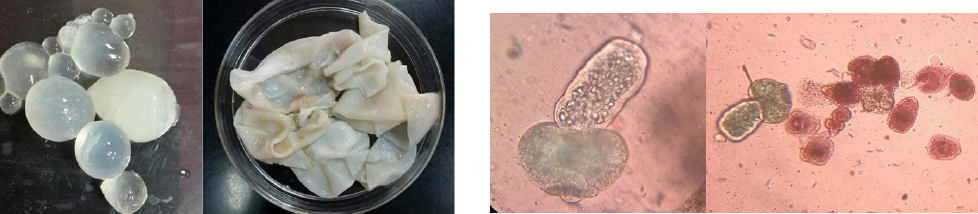
Fig. 3. Brood capsules and germinal layer isolated from sheep hydatid cysts